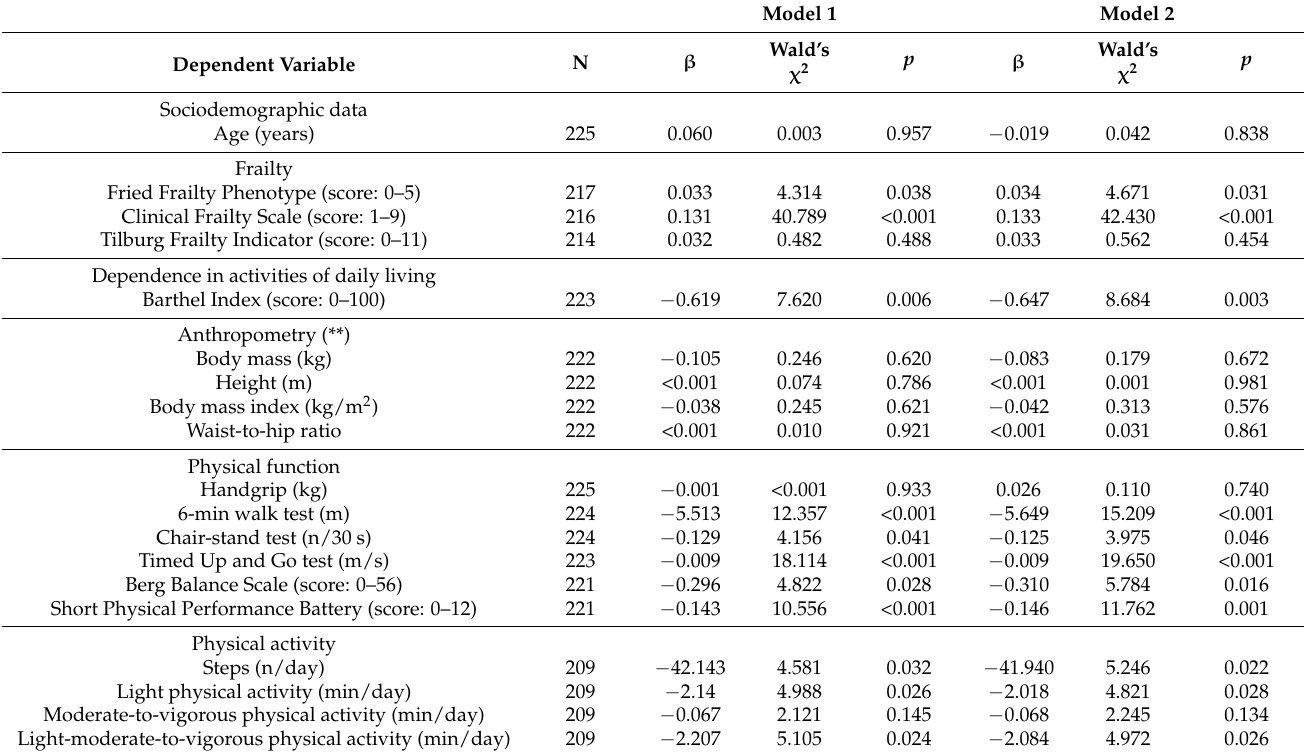
Table 3. Generalized linear models for the analyzed variables as dependent variables. Model 1: for the serum sestrin-1 concentration as a predictor variable. Model 2: for the serum sestrin-1 concentration as a predictor variable, age and BMI were considered as covariables, and sex was considered as a factor. In the case of anthropometry variables, BMI was not used as a covariable